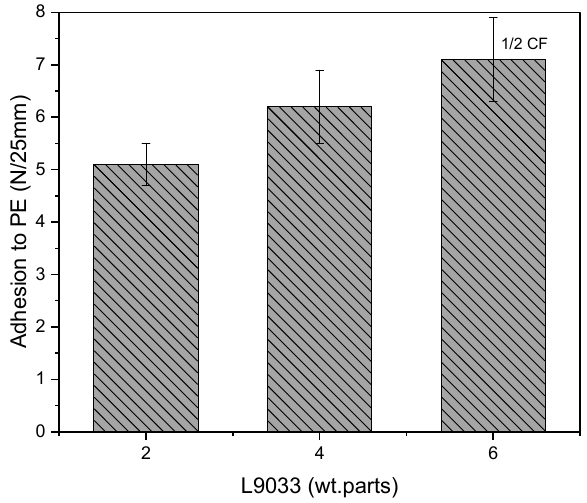
L9033 (wt.parts) Figure 7. Adhesion to PE of PSA (with the FT5/L30 syrup; UV dose of 8 J/cm 2 ) in relation to aliphatic urethane acrylate content; ½ CF—partial cohesive failure.